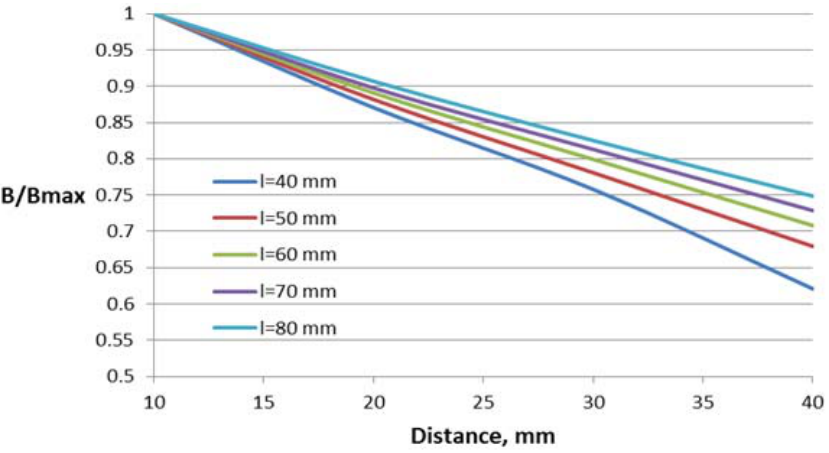
Figure 10. Dependence of the flux density on the distance to the conductor for the concentrator with two gaps and different window lengths l .